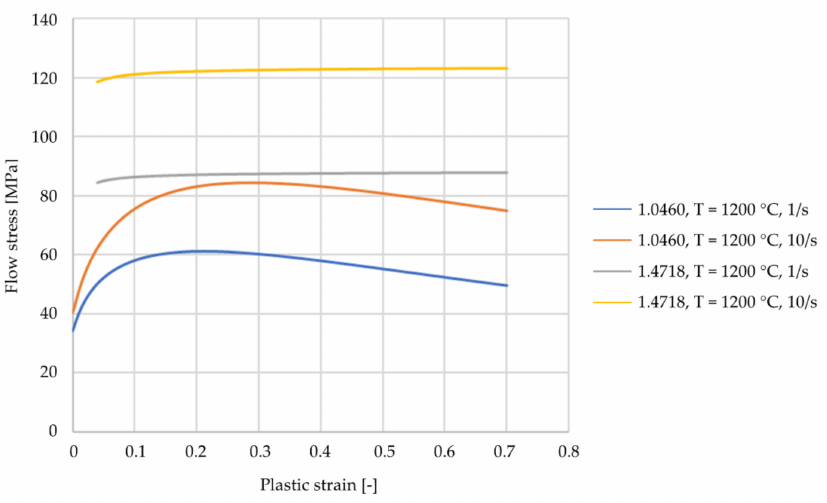
Figure 5. Flow curves for 1.0460 and 1.4718 in